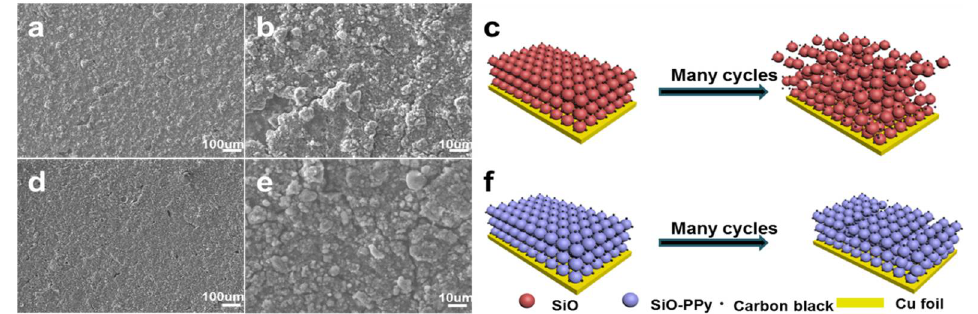
Figure 4. ( a – c ) Scanning electron microscopy (SEM) images and corresponding schematic illustration of the pure SiO electrode after 50 cycles at a current density of 0.1 C; ( d – f ) SEM images and corresponding schematic illustration of SiO–PPy–500 electrode after 50 cycles at a current density of 0.1 C.